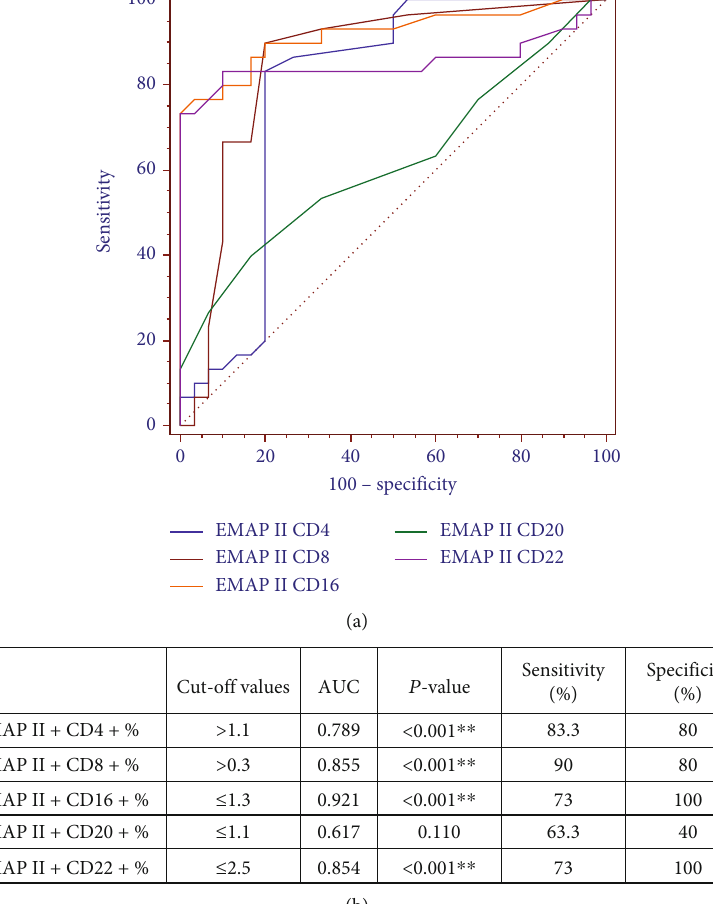
Figure 6: Diagnostic performances of percentages of EMAP II+CD4, EMAP II+CD8+, EMAP II+CD16+, EMAP II+CD20+, and EMAP II +CD22+ for identifying NHL patients with complete remission. (a) ROC curves were gained by curves at di ff erent cut-o ff s for NHL patients. (b) AUC (area under the curve) with cut-o ff s, sensitivity, and speci fi city for the markers. High statistical signi fi cance ( P < 0 : 001 ) is identi fi ed with ∗∗